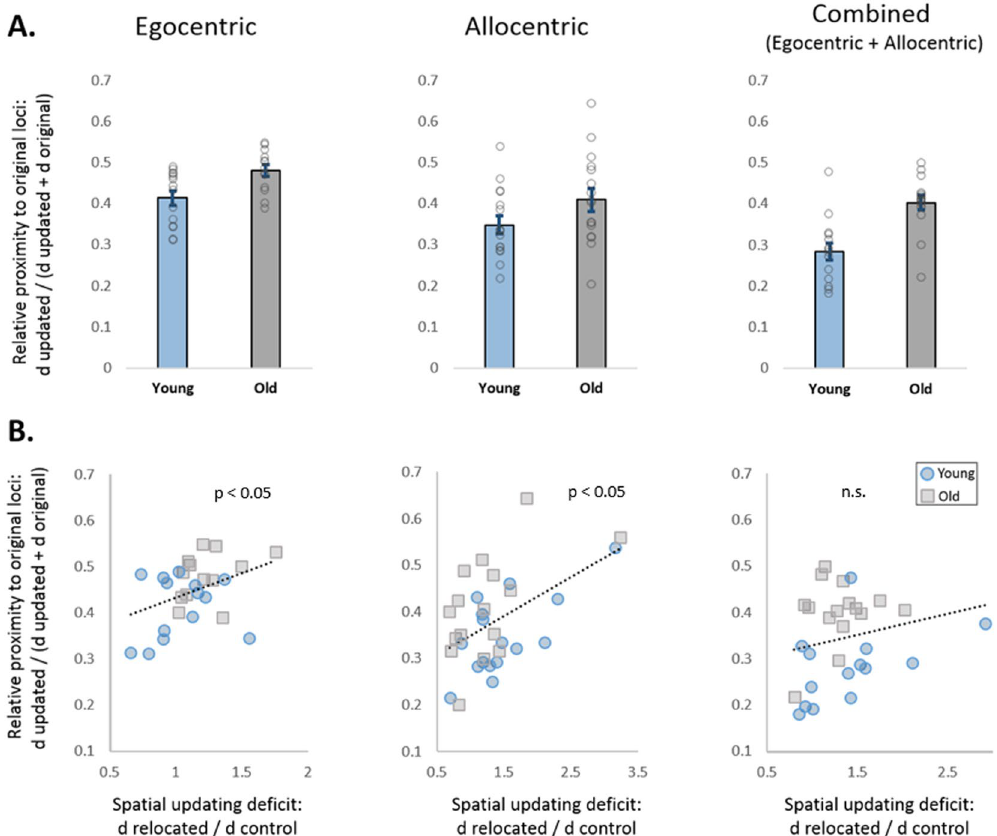
Figure 4. Older participants show stronger representations of the former navigational context, which are correlated with the spatial updating deficits. ( A ) Effects of the original locations on the retrieval of the updated ones. Higher bars indicate a greater effect of the original loci on the retrieval of the updated ones. Across conditions, this effect was found to be stronger in old age. ( B ) Spatial updating deficit is associated with stronger representations of the original navigational context. In the egocentric and the allocentric conditions, the effect of the original loci on retrieval of the updated ones was positively correlated with the spatial updating deficit. Data are presented as mean ±